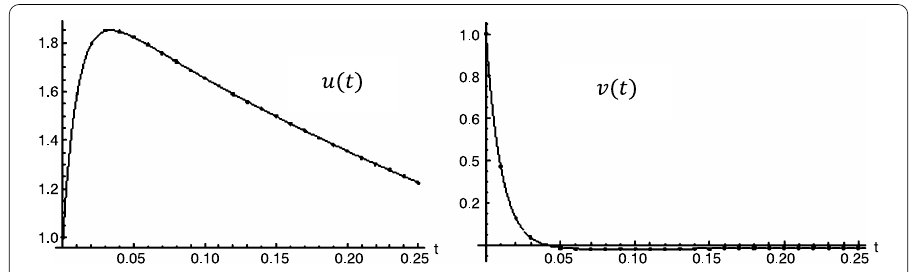
Figure 1 The behavior of FRPS solution of Example 4.1: __ exact; ... .